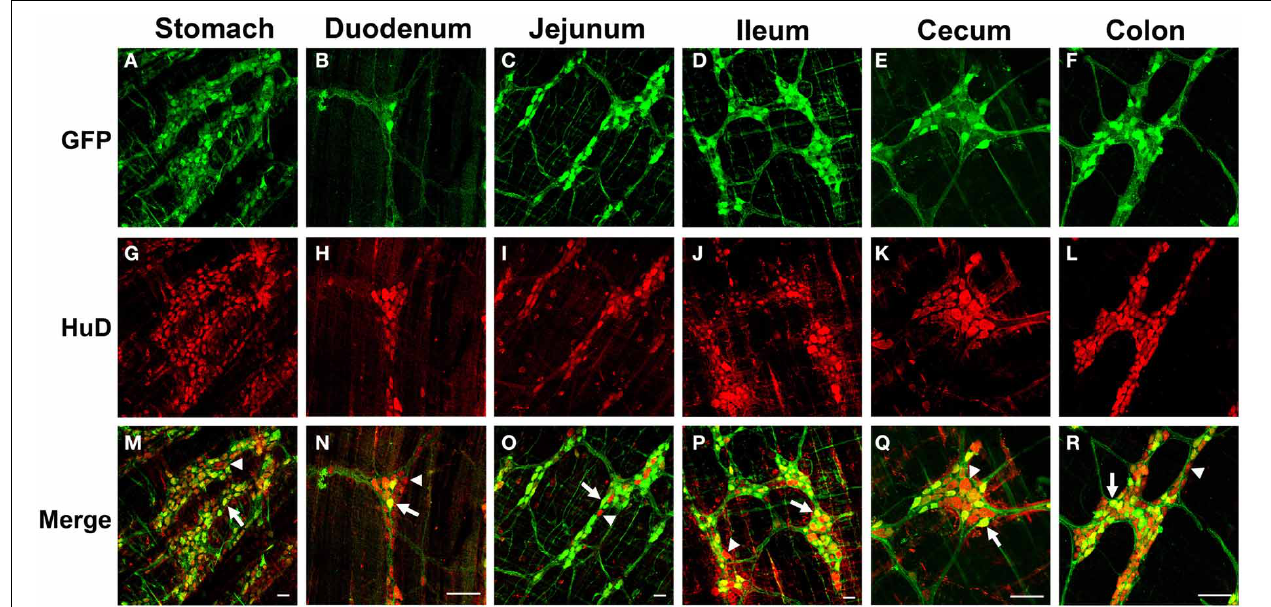
FIGURE 2 | Green fluorescent protein (GFP) expression in the myenteric plexus following intravenous injection of scAAV9-CB-GFP into juvenile mice. Intravenous injection of scAAV9-CB-GFP into P21 mice resulted in robust GFP (green, A–F ) expression in neurons (HuD, red, G–L ) in the